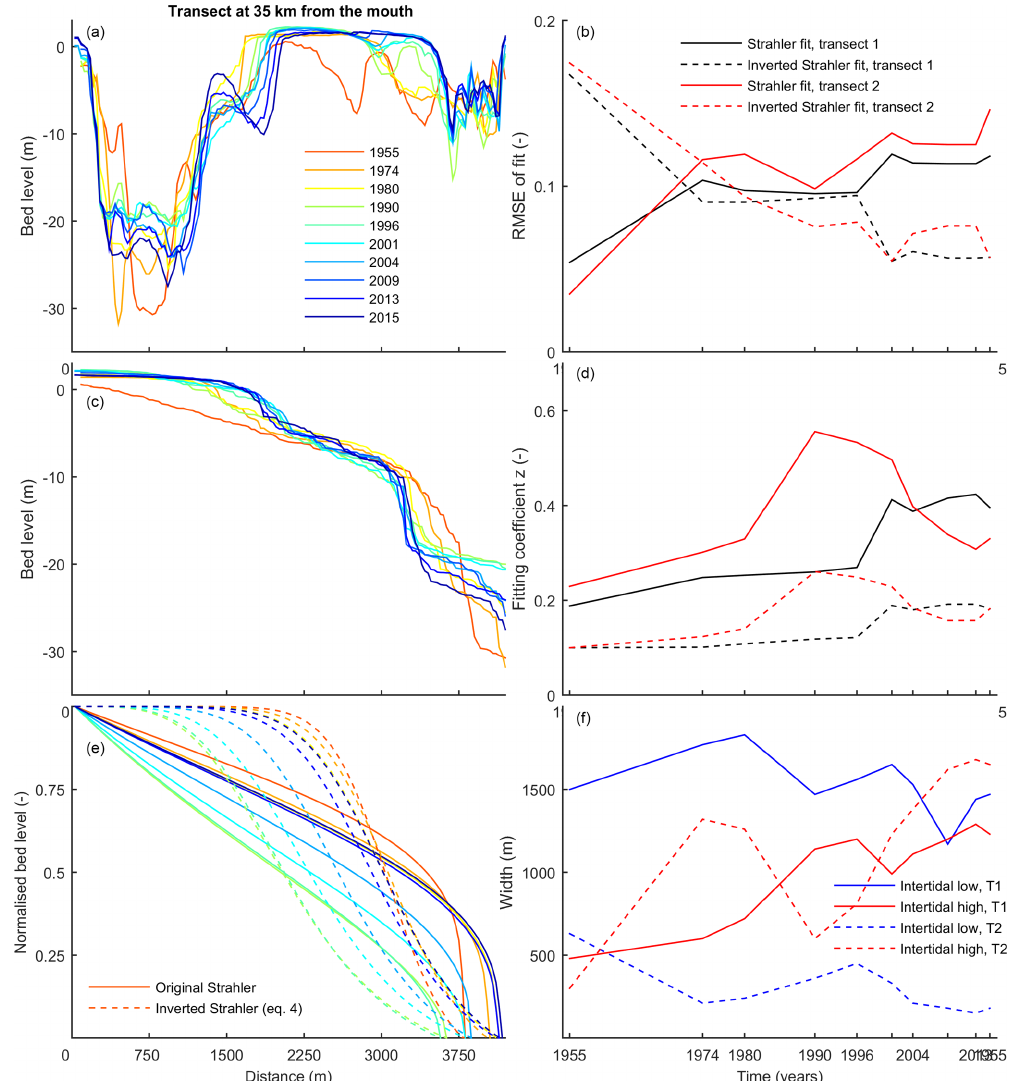
Figure 13. (a) Evolution of a cross section in the Western Scheldt where it has been significantly dredged and dumped (the Drempel van Hansweert). (c) Measured hypsometric profiles of the same time steps at the same cross section. (e) Best-fit hypsometries using the original Strahler equation (solid) and inverted Strahler function (Eq. 4) (dashed). (b) The quality of the two types of fits shows that the shape of the best-fitting hypsometric curve changes from the original Shrahler to the inverted equation in the 1970s–1980s. An additional transect is added in the panels on the right. (d) Fitting coefficients for z increase over time for both hypsometry types and both transects. (f) Intertidal high area increased over this period, while intertidal low area remained constant (transect 1) or decreased (transect